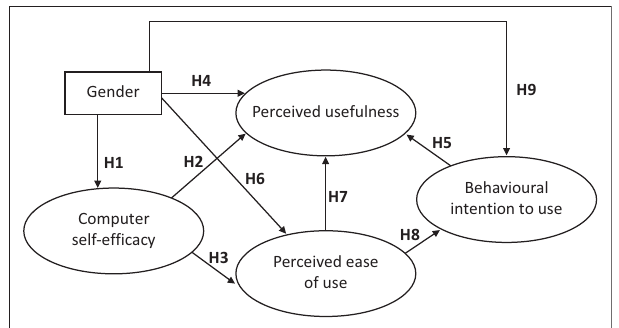
FIGURE 1: Research